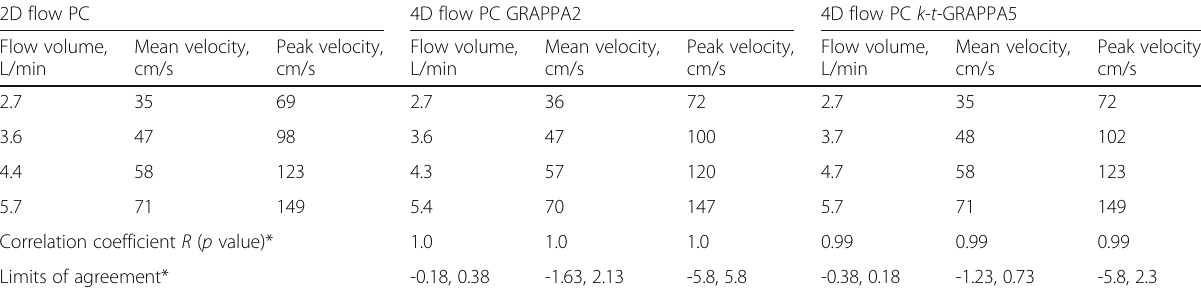
2D two-dimensional, 4D four-dimensional, cm/s centimetres per second, GRAPPA generalised autocalibrating partially parallel acquisition, L/min litres per minute, PC phase-contrast *Correlation coefficients and limits of agreement between the 4D flow PC GRAPPA2 and k - t -GRAPPA5 with the 2D flow PC sequences used as the reference standard